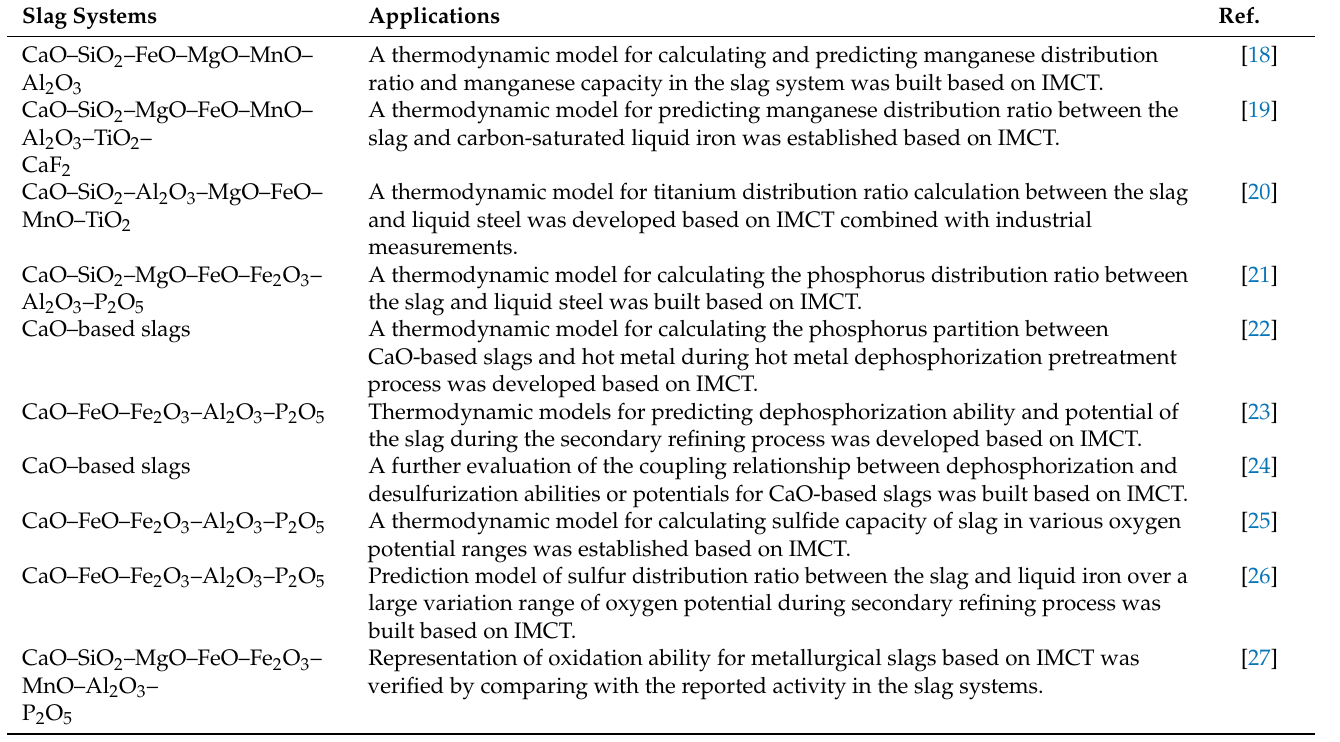
Table 1. The applications of IMCT model during ironmaking and steelmaking processes. Slag Systems Applications